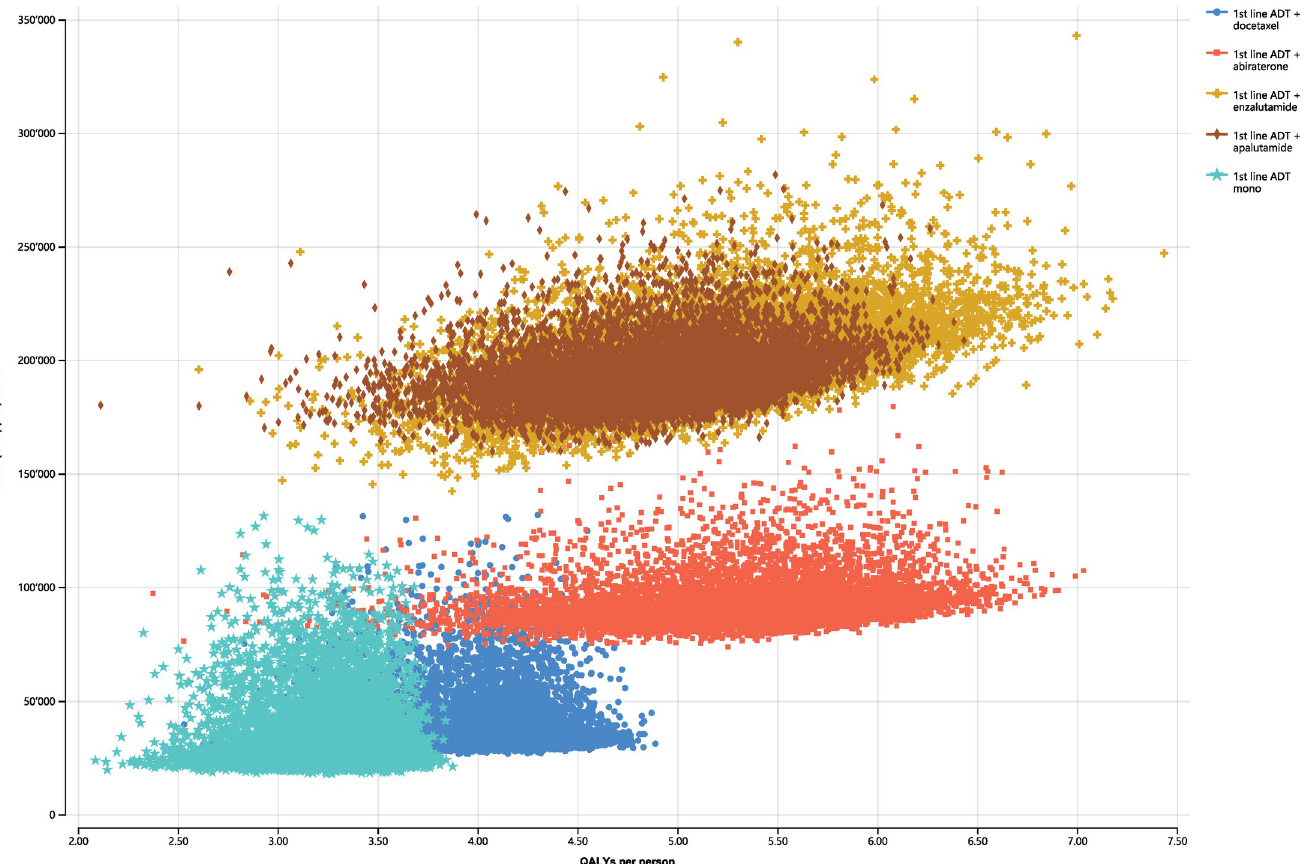
Fig 3. Cost-effectiveness scatter plot based on probabilistic sensitivity analysis. ADT, androgen deprivation therapy; EUR, euros; QALYs, quality-adjusted life years.